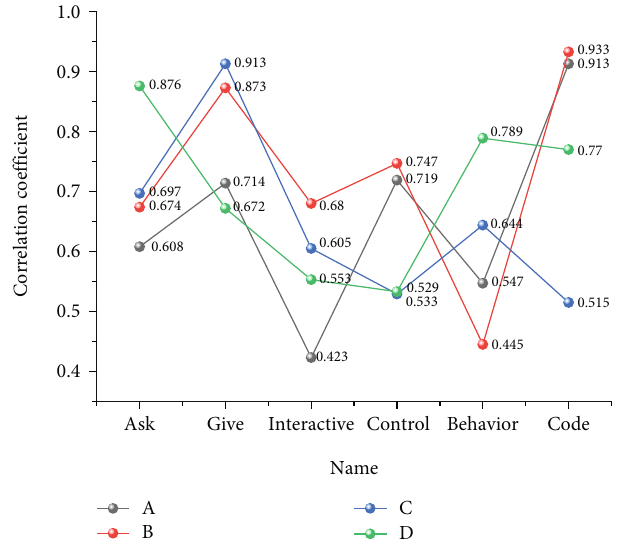
Figure 4: Relevance